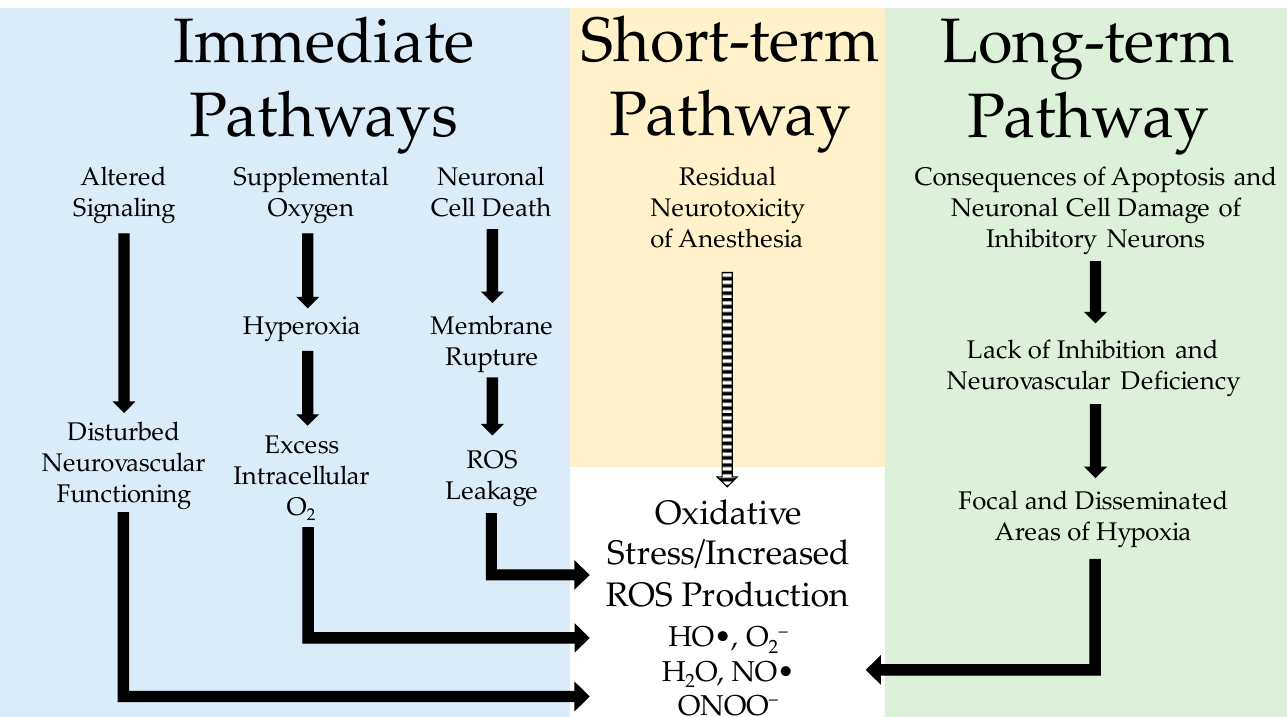
Figure 1. Schematic illustration of neonatal anesthesia-induced oxidative stress in the brain. During the administration of neonatal anesthesia, there are three immediate pathways (blue) for how oxidative stress (red) can manifest. These immediate pathways have three distinct sources, altered signaling, administration of supplemental oxygen, and neuronal cell death; each of these can increase the concentration of ROS and induce oxidative stress. The short-term pathway (yellow) appears to be less impactful since it is short-lived; this is shown in the figure with a dashed arrow. The long-term pathway (green) shows the delayed effects of neonatal anesthesia and how the initial damage to neurons can negatively affect neurovascular interactions, leading to oxidative stress.